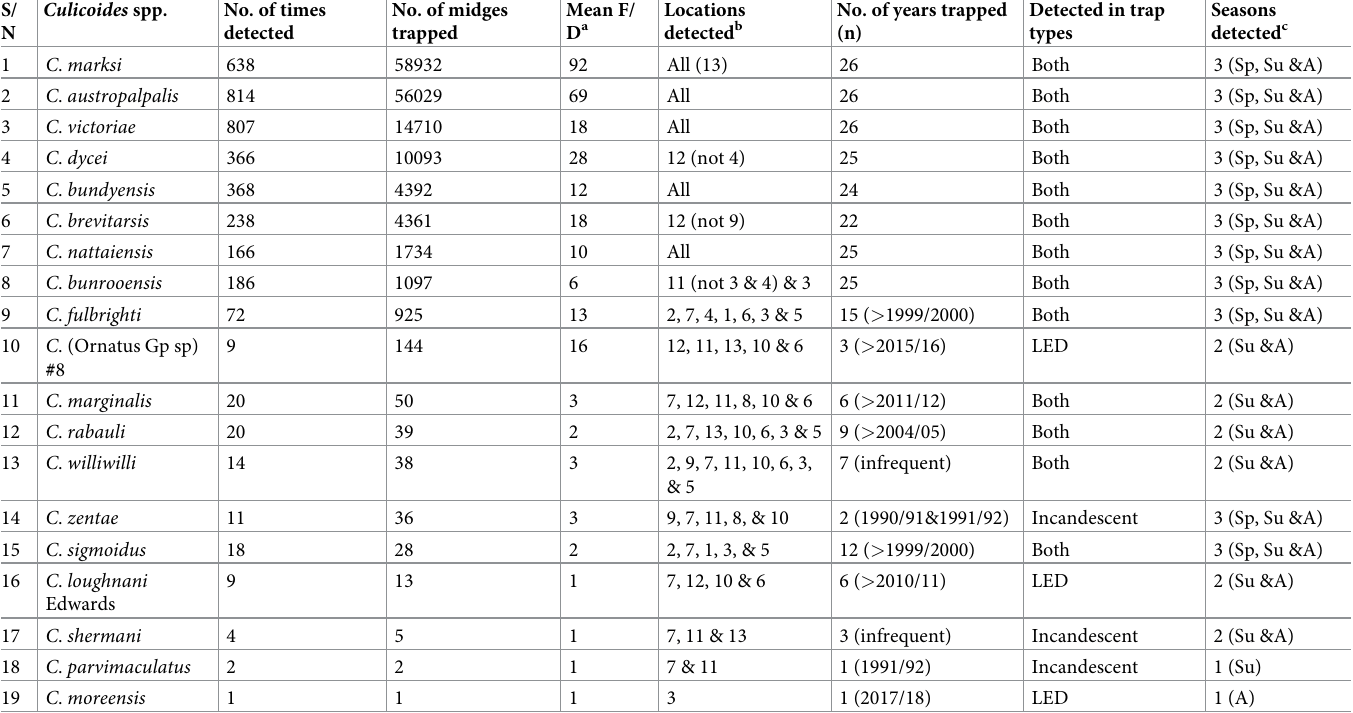
Table 2. Abundance of Culicoides species trapped from the New England region of NSW, Australia between 1990 and 2018 showing years, seasons and locations of trapping. S/ Culicoides spp. N